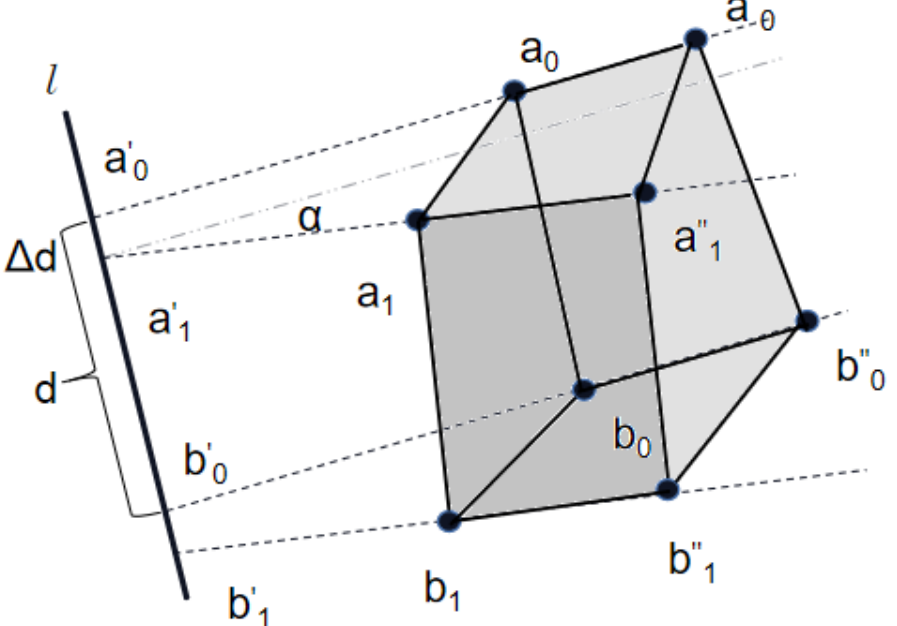
Figure 5. Spatial quadrilateral extends to the hexahedron.